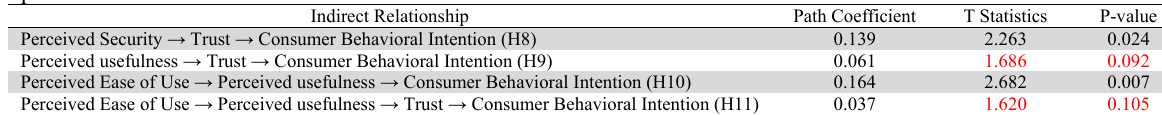
Specific Indirect Path Coefficient and T